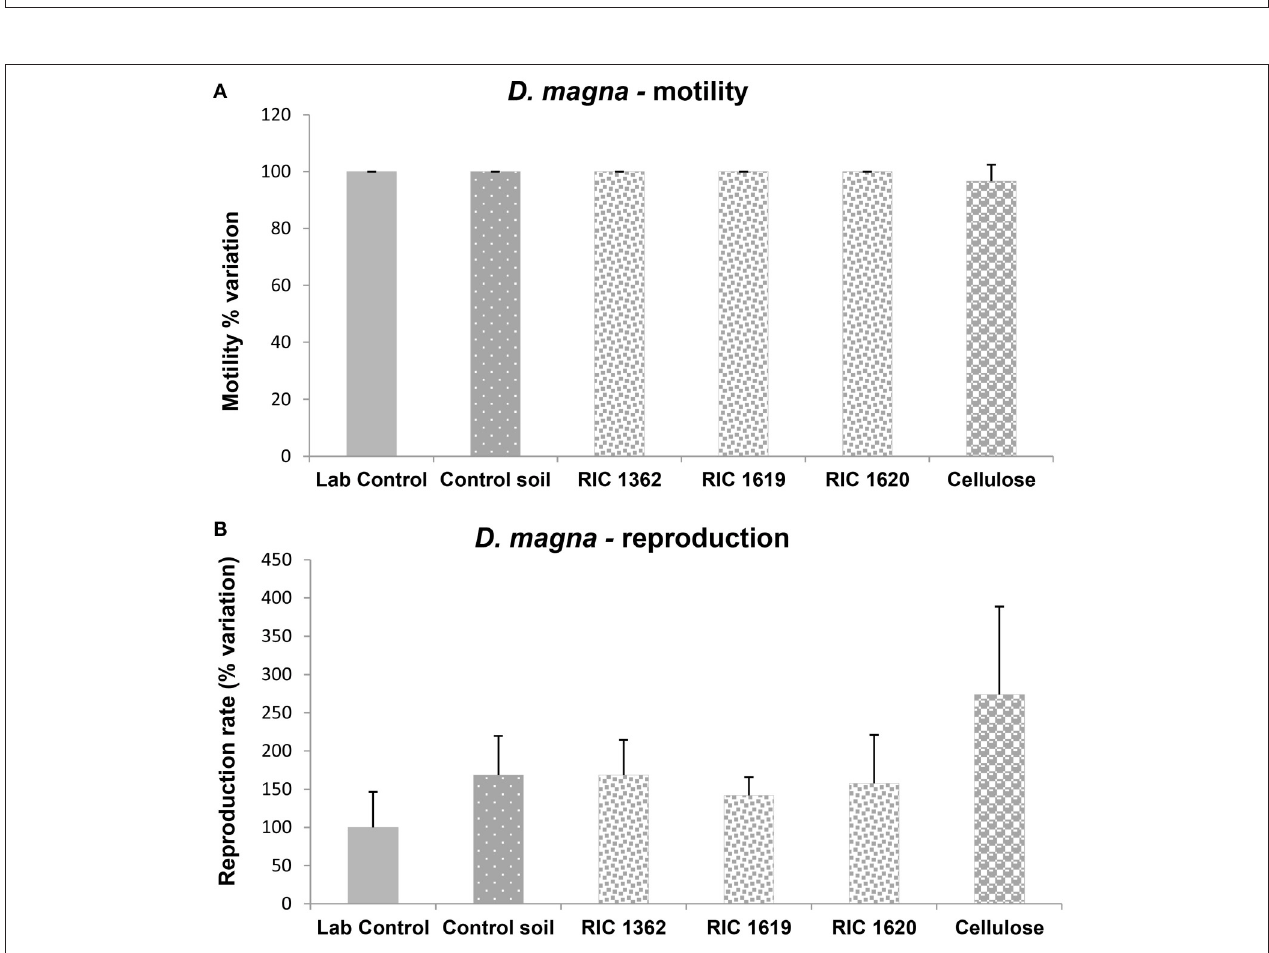
FIGURE 6 | Motility (A) and reproduction (B) of D. magna after exposure to the elutriate samples. Data, expressed as % variation (A) and % variation with respect to lab control (B) , represent the mean ± SD of at least five replicates. *Indicates statistically significant differences with respect to lab control values ( p < 0.05 Mann–Whitney U -test). RIC 1362, RIC 1619, RIC 1620, Mater-Bi soils; Cellulose, soil containing cellulose reference material.